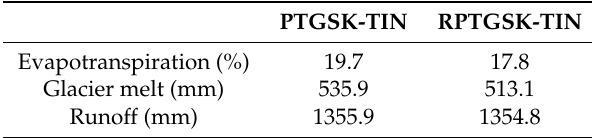
Table 6. Annual (2005) water balance components for Marshyangdi_2 river